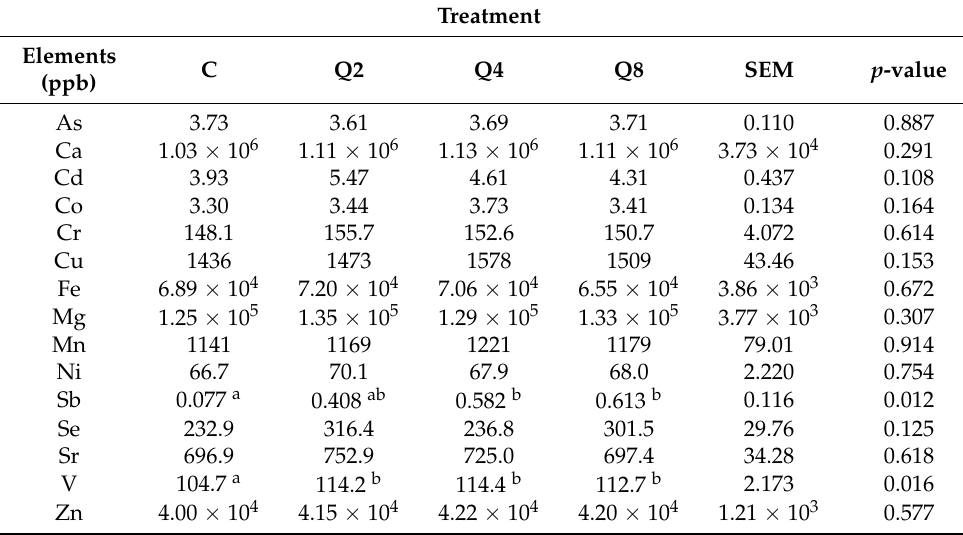
Table 2. The effect of dietary supplementation with quercetin on selected trace- and macro-elements concentrations in laying hens’ egg yolk ( n = 7).